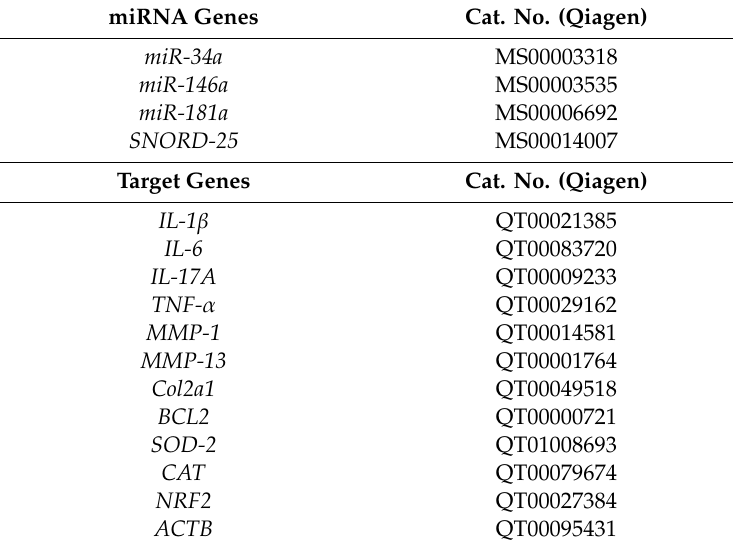
Table 1. Primers used for